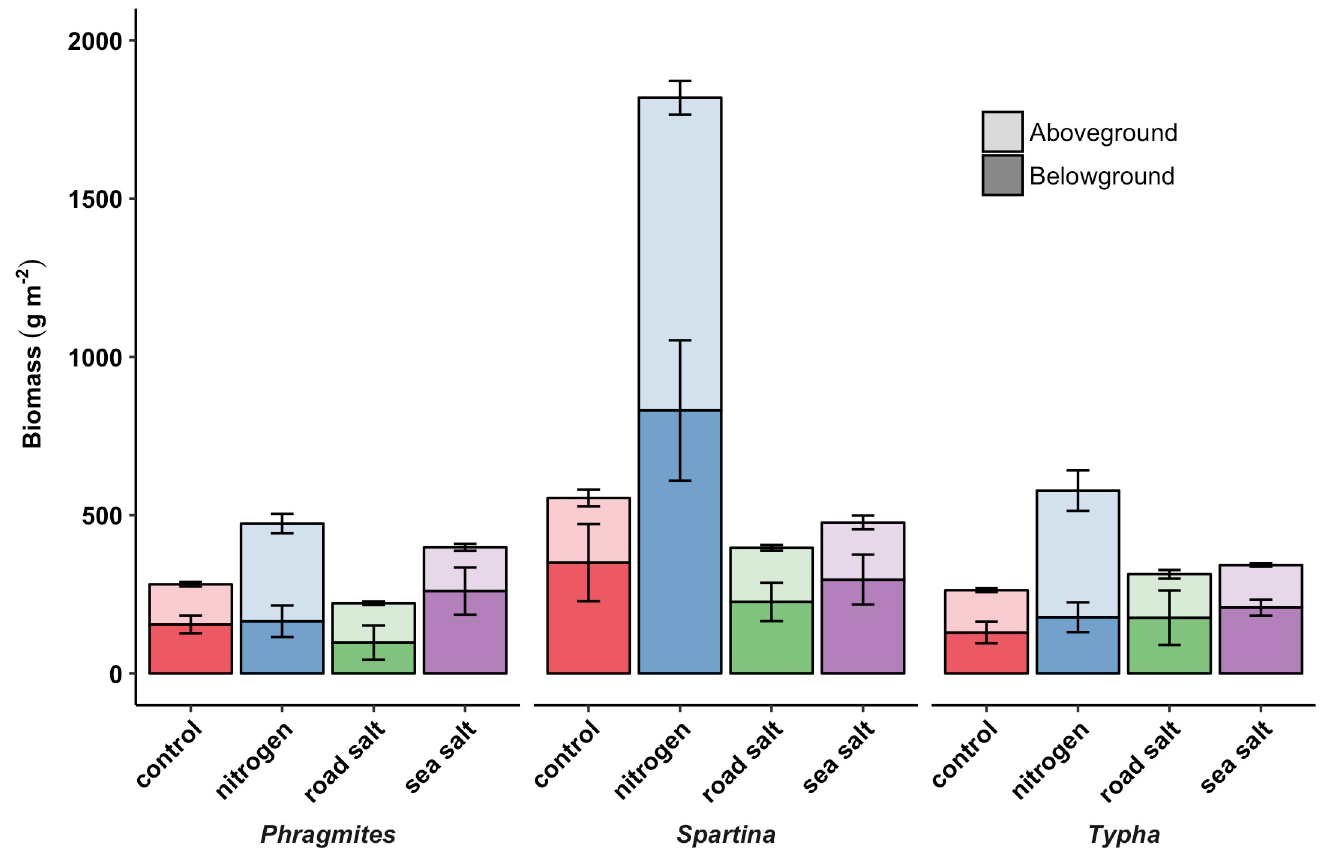
Fig 1. Biomass allocation by vegetation species-water quality treatment combinations. Mean ( ± SE) above- and belowground biomass by species-water quality combinations in 2017 in a full factorial mesocosm experiment where each treatment combination was replicated four-fold.